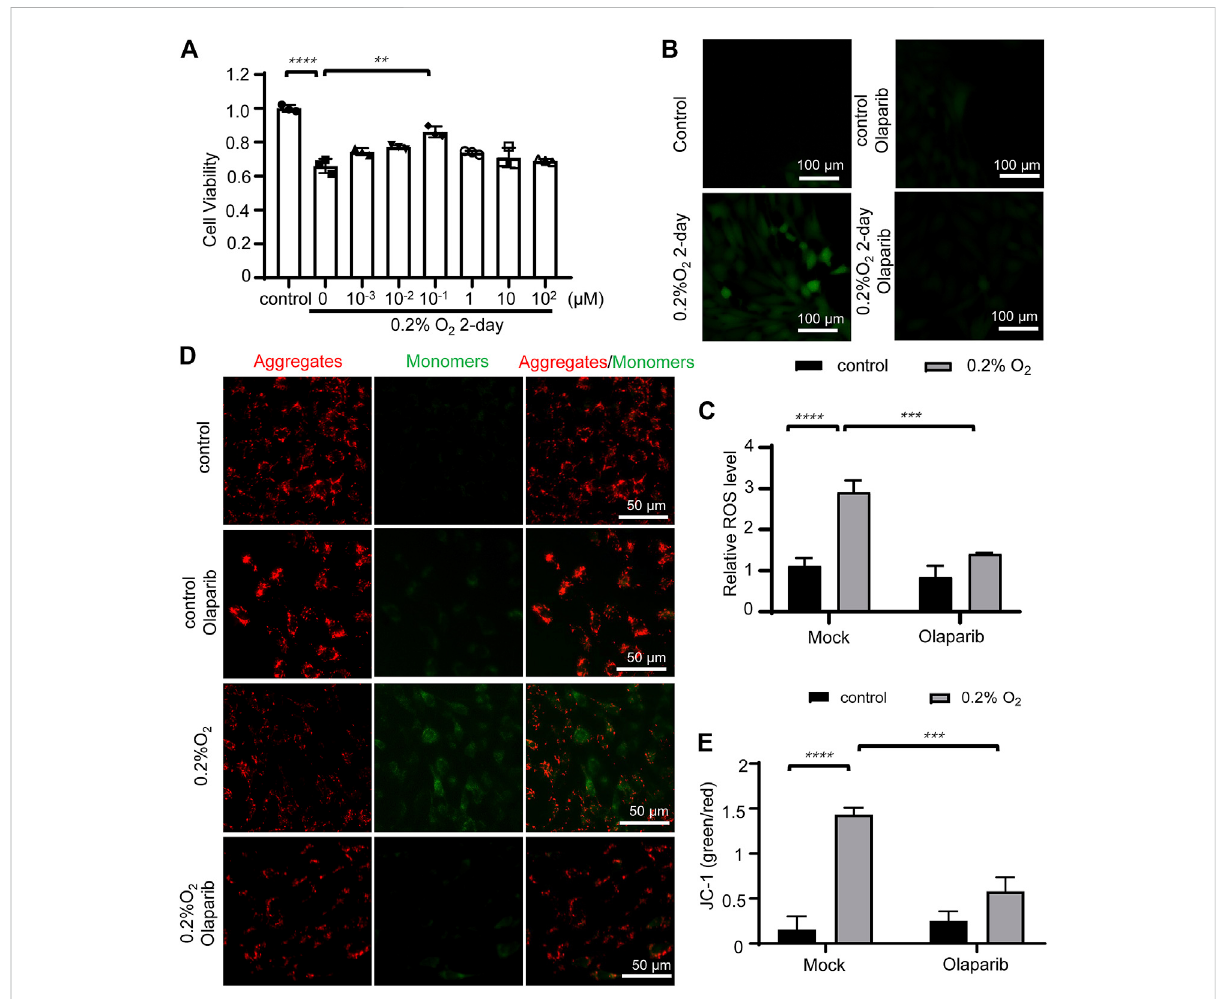
FIGURE 7 Olaparib alleviateshypoxicstimulation-induced cellviability loss,ROS accumulation,andMMPcollapse. (A) Olaparib(100 nM)rescuedR28cell viability under hypoxia-induced oxidative stress. The p -value was determined using two-way ANOVA with Dunnett ’ s test for multiple comparisons. Representative images (B) and the relative ROS fl uorescent intensity (C) in the control, control + olaparib, microbead, and microbead + olaparib groups. Data are presented as the means ± SEM. The p -values were determined using two-way ANOVA with Sidak ’ s test for multiple comparisons.Representativeimages (D) andtherelativeJC-1greentored fl uorescentintensityratios (E) oftheaforementionedgroupscomparedto the control group were calculated using the ImageJ software and p -values were determined using one-way ANOVA with Tukey ’ s test for multiple comparisons. pp p < 0.01, ppp p < 0.001, and pppp p <